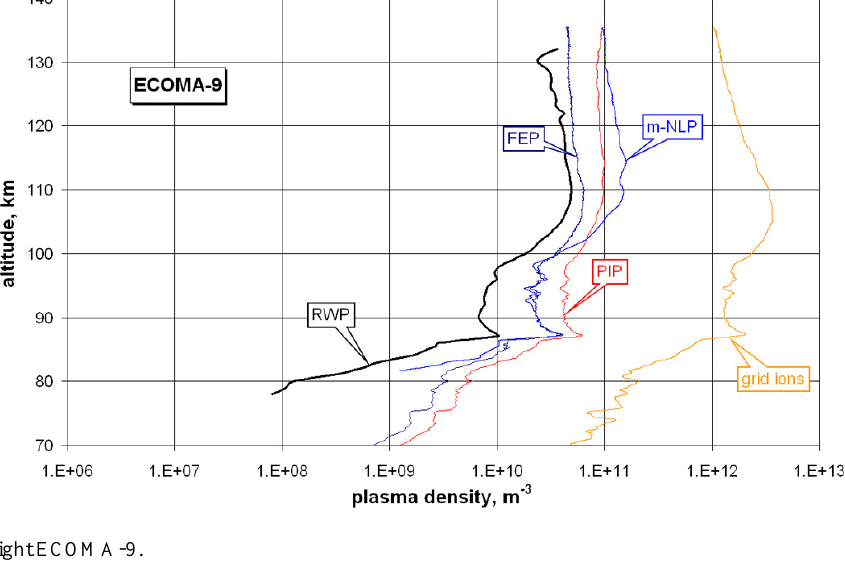
Fig. 9. As Fig. 3, but flight ECOMA-9.